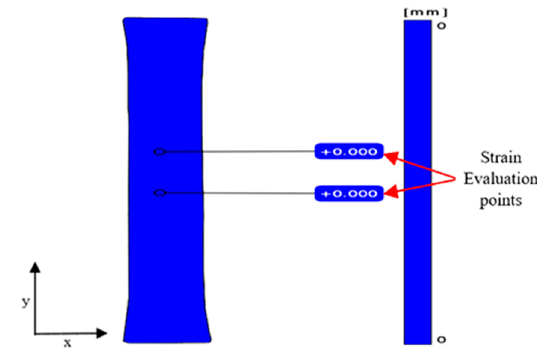
Figure 15. Reference digital image correlation (DIC) image of the tensile specimen.